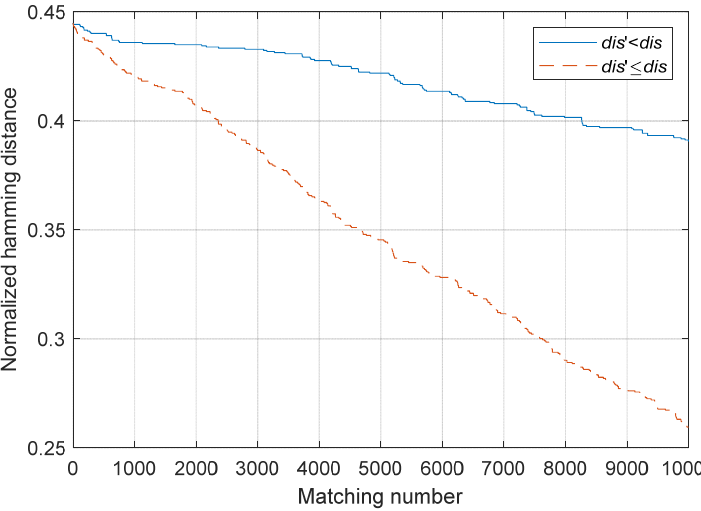
Figure 5. Two modification modes when distance is not changed.